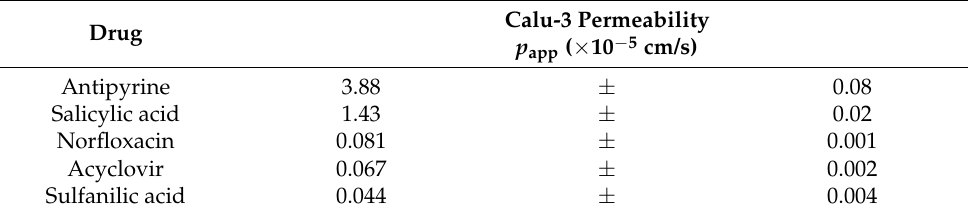
Table 3. Membrane permeability across Calu-3 cell layers ( p app ) with five model drugs.